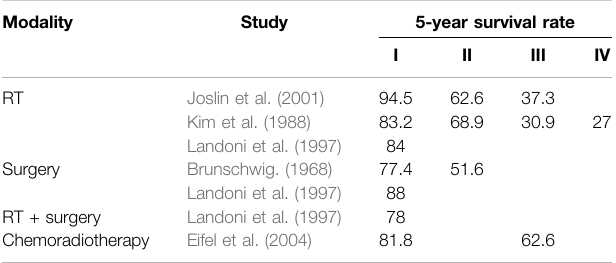
TABLE 1 | The reported actual clinical